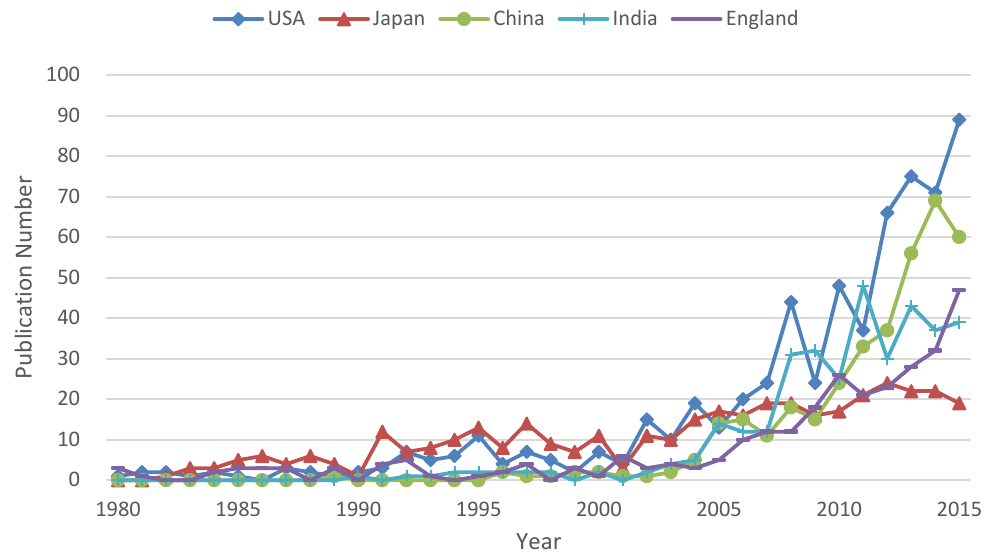
Figure 3. Annual publication numbers of top five productive countries.